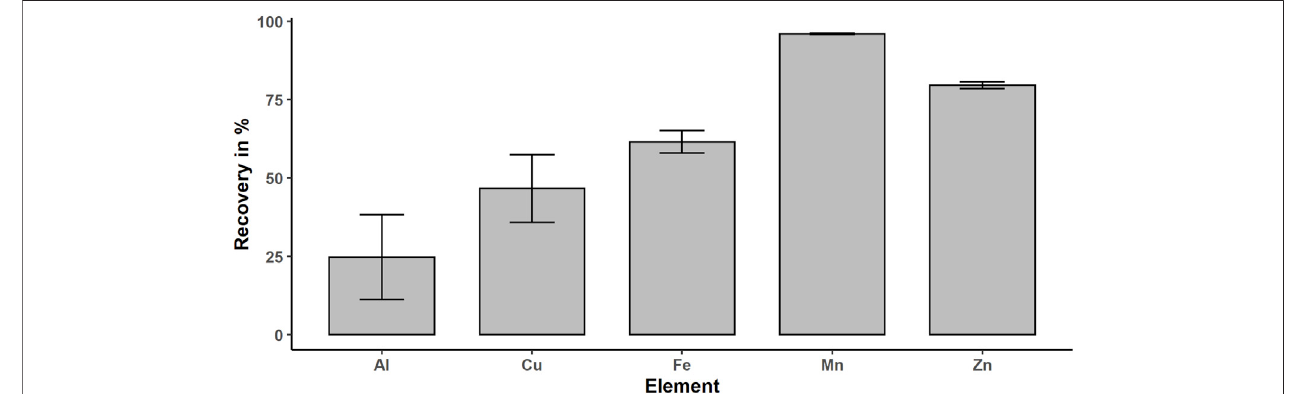
FIGURE 3 | Obtained recoveries for extracted metals: Fe, Mn, Al, Cu, and Zn.